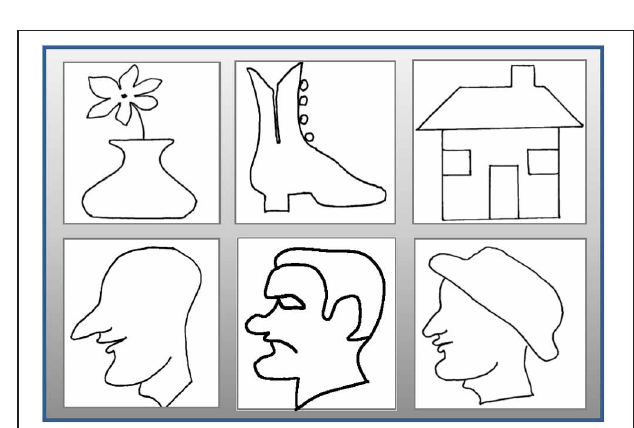
FIGURE 3 | Raised-line drawing models. Realistic faces and objects explored by the subject using her left hand in the E/M task were drawn from memory in the MD task after a 20s rest interval. Two repetitions of each of the six stimuli were run in each fMRI session for total of 12 runs per